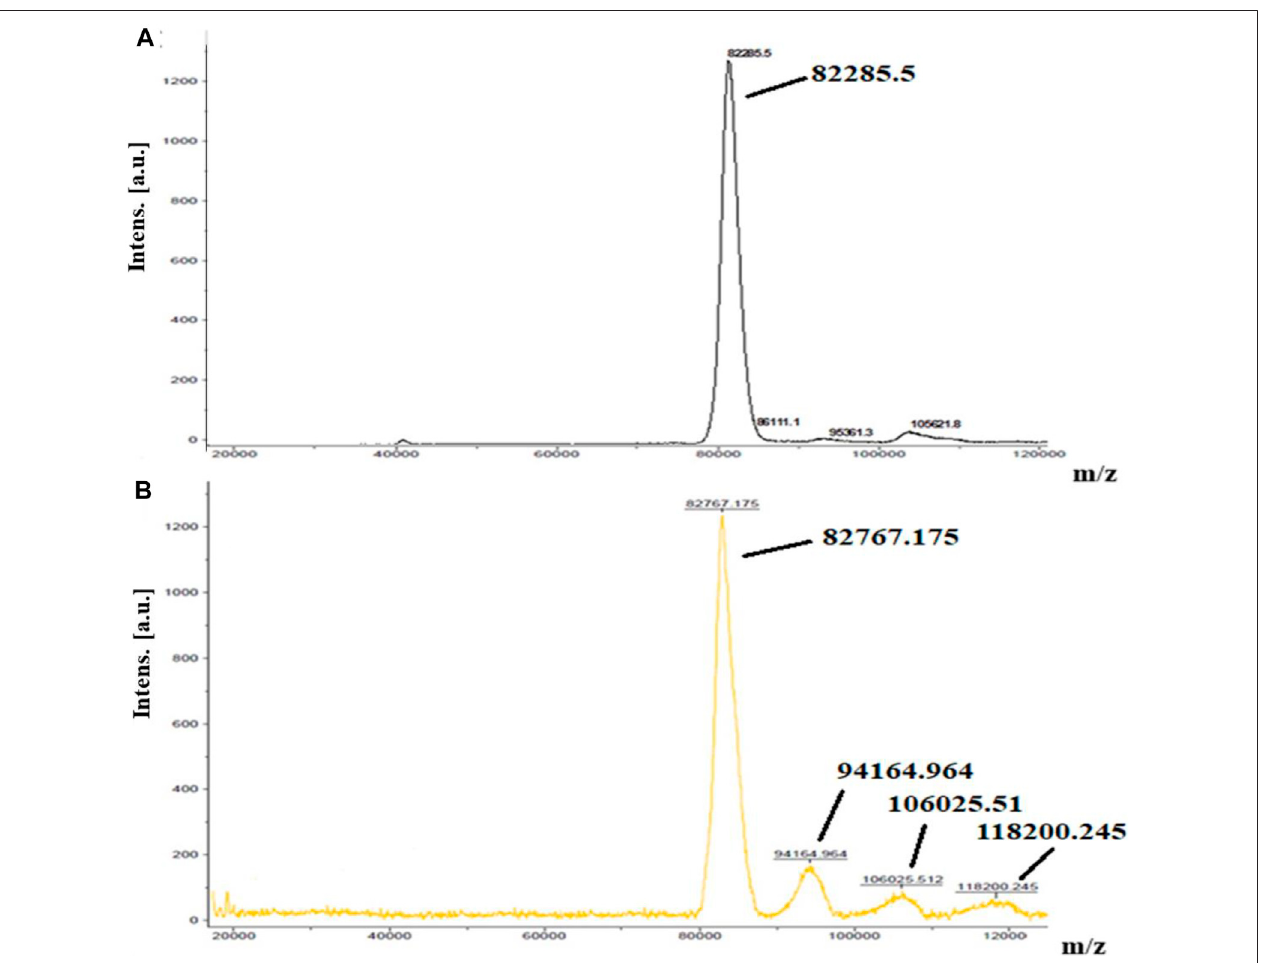
FIGURE 2 | MALDI TOF mass spectra of (A) Lf and (B) MTX – Lf conjugate F3 .